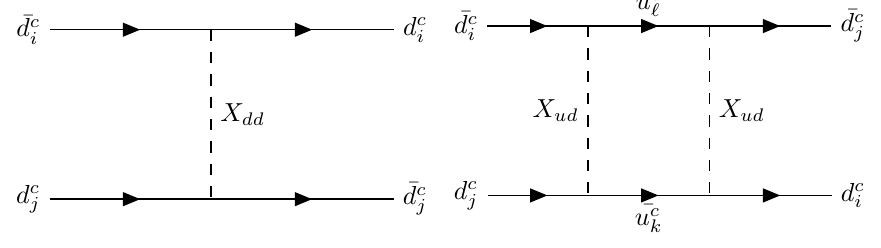
Figure 11 . Tree- (left) and loop-level (right) meson oscillation diagrams mediated by the diquarks X dd or X ud